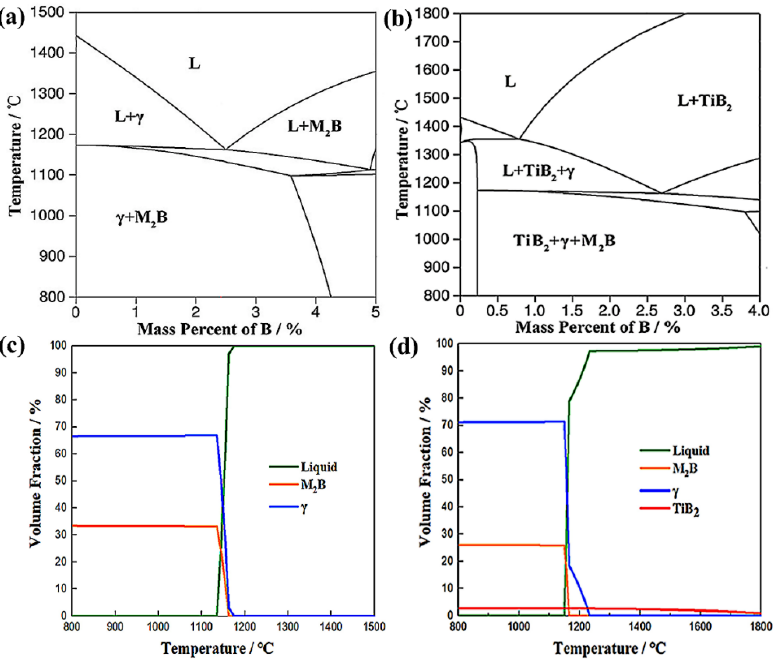
Figure 5. Pseudo-binary Fe–B phase diagrams based on the Ti-adding ( a ) and Ti-free steels ( b ) in the temperature range of 800~1500 °C, volume fraction diagrams of stable phases for the Ti-adding ( c ) and Ti-free steels ( d ) [33].